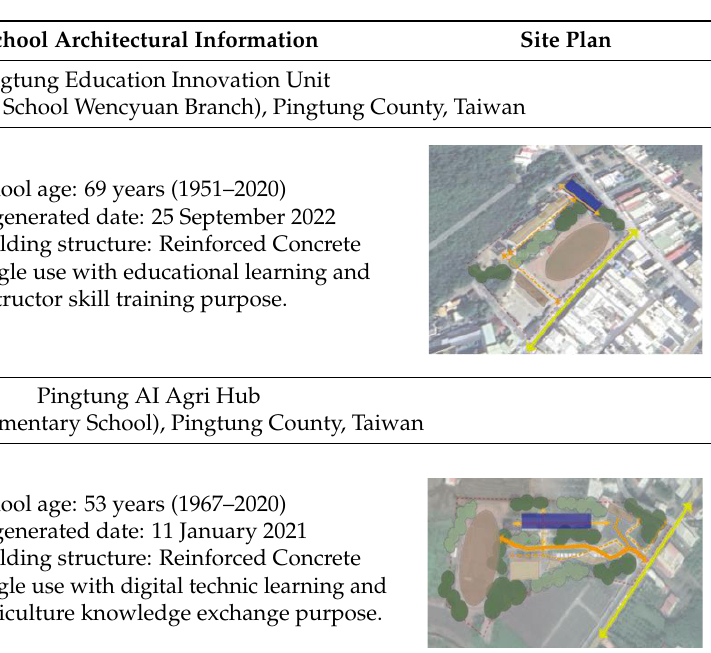
Table 1. Description of Redesign School Architecture.